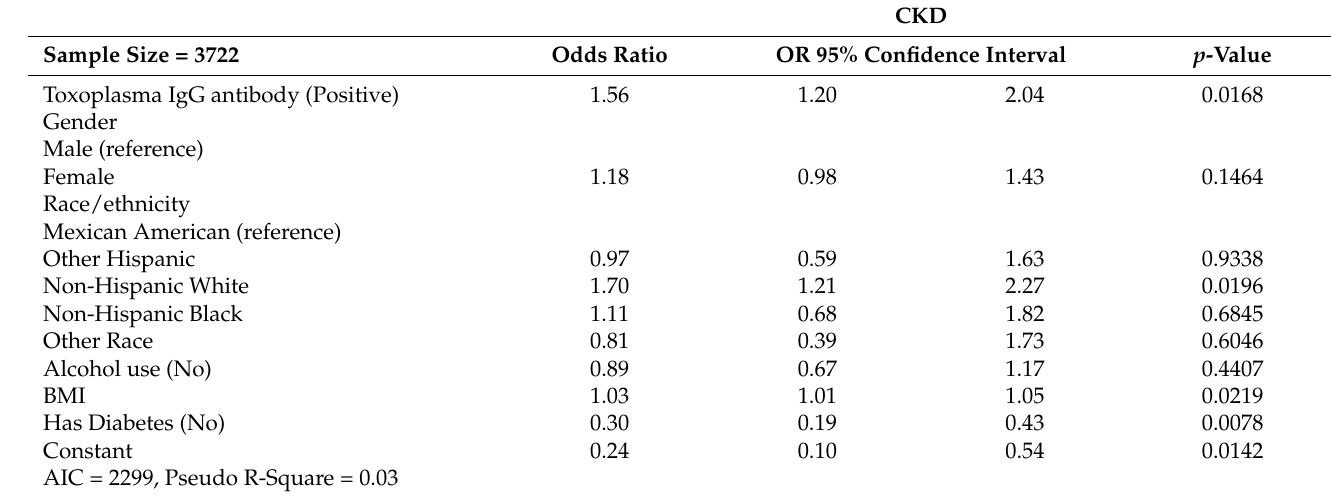
Table 6. Binomial Logistic regression model for CKD status on T. gondii IgG antibody (posi- tive/negative) adjusted for the demographic factors (except age) and other covariates.